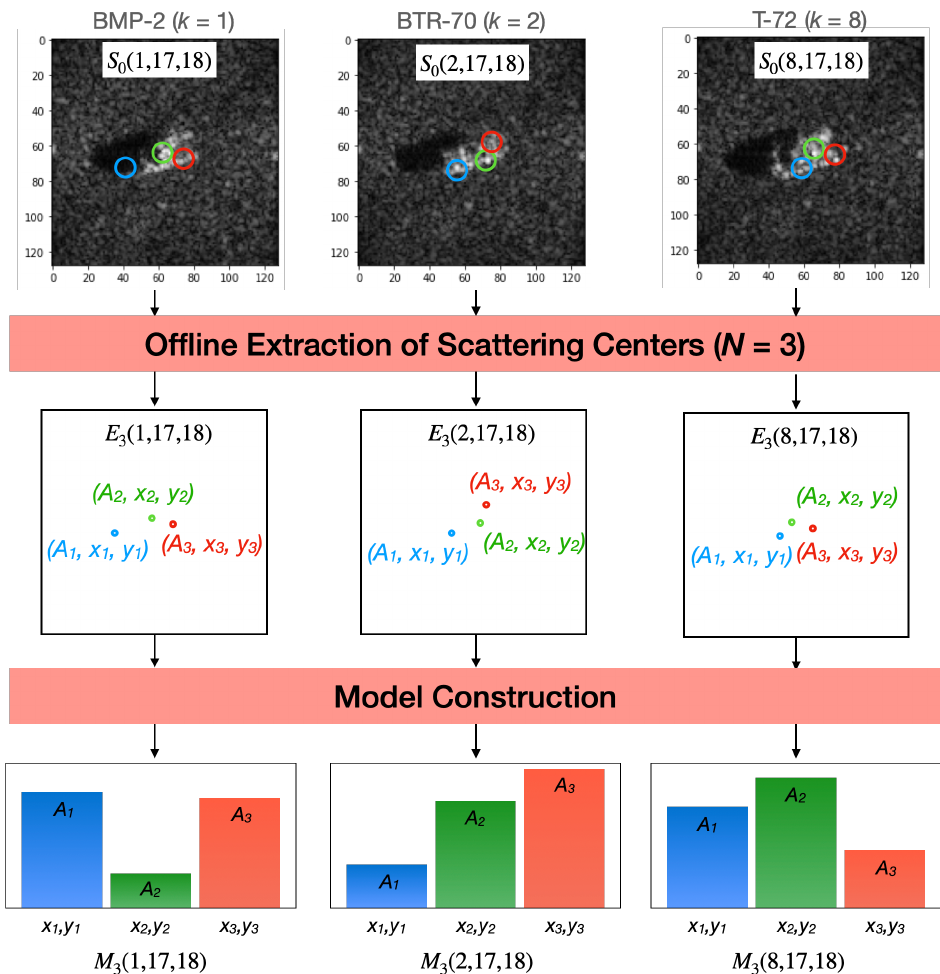
Figure 9. Illustrative example of the construction of three different class models (BMP-2, BTR-70 and T-72) at the same aspect angles ( θ = 17 ◦ and φ = 18 ◦ ) with three scattering centers